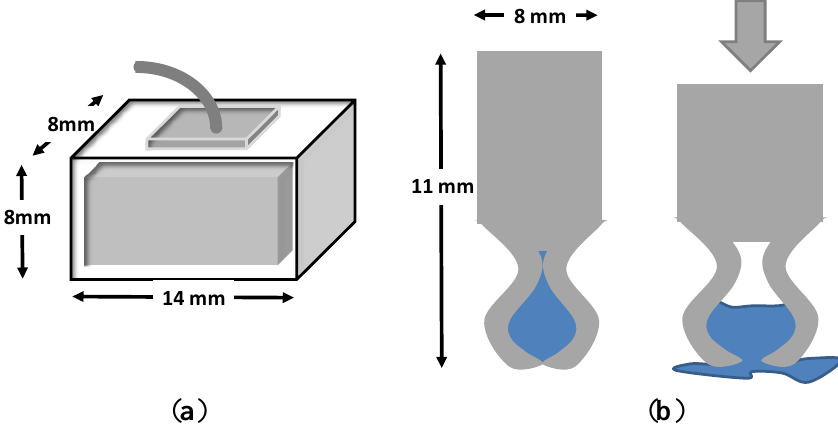
Figure 5. ( a ) Dry foam EEG electrode. Adapted from [5]; ( b ) Quasi-dry electrode